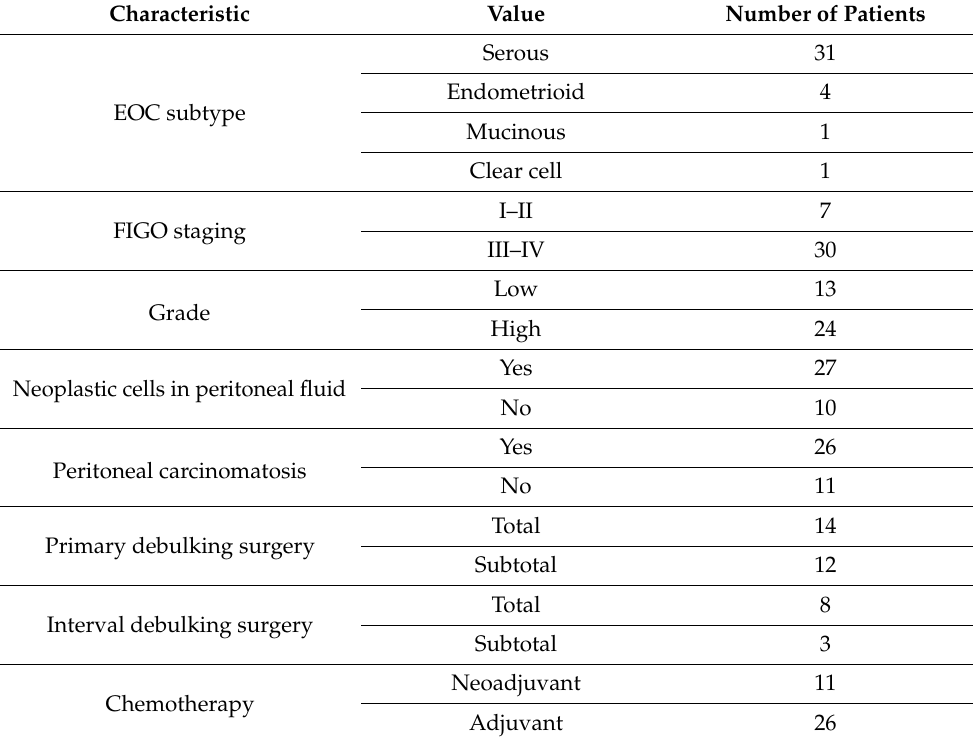
Table 1. Clinicopathological characteristics for the enrolled ovarian cancer patients.